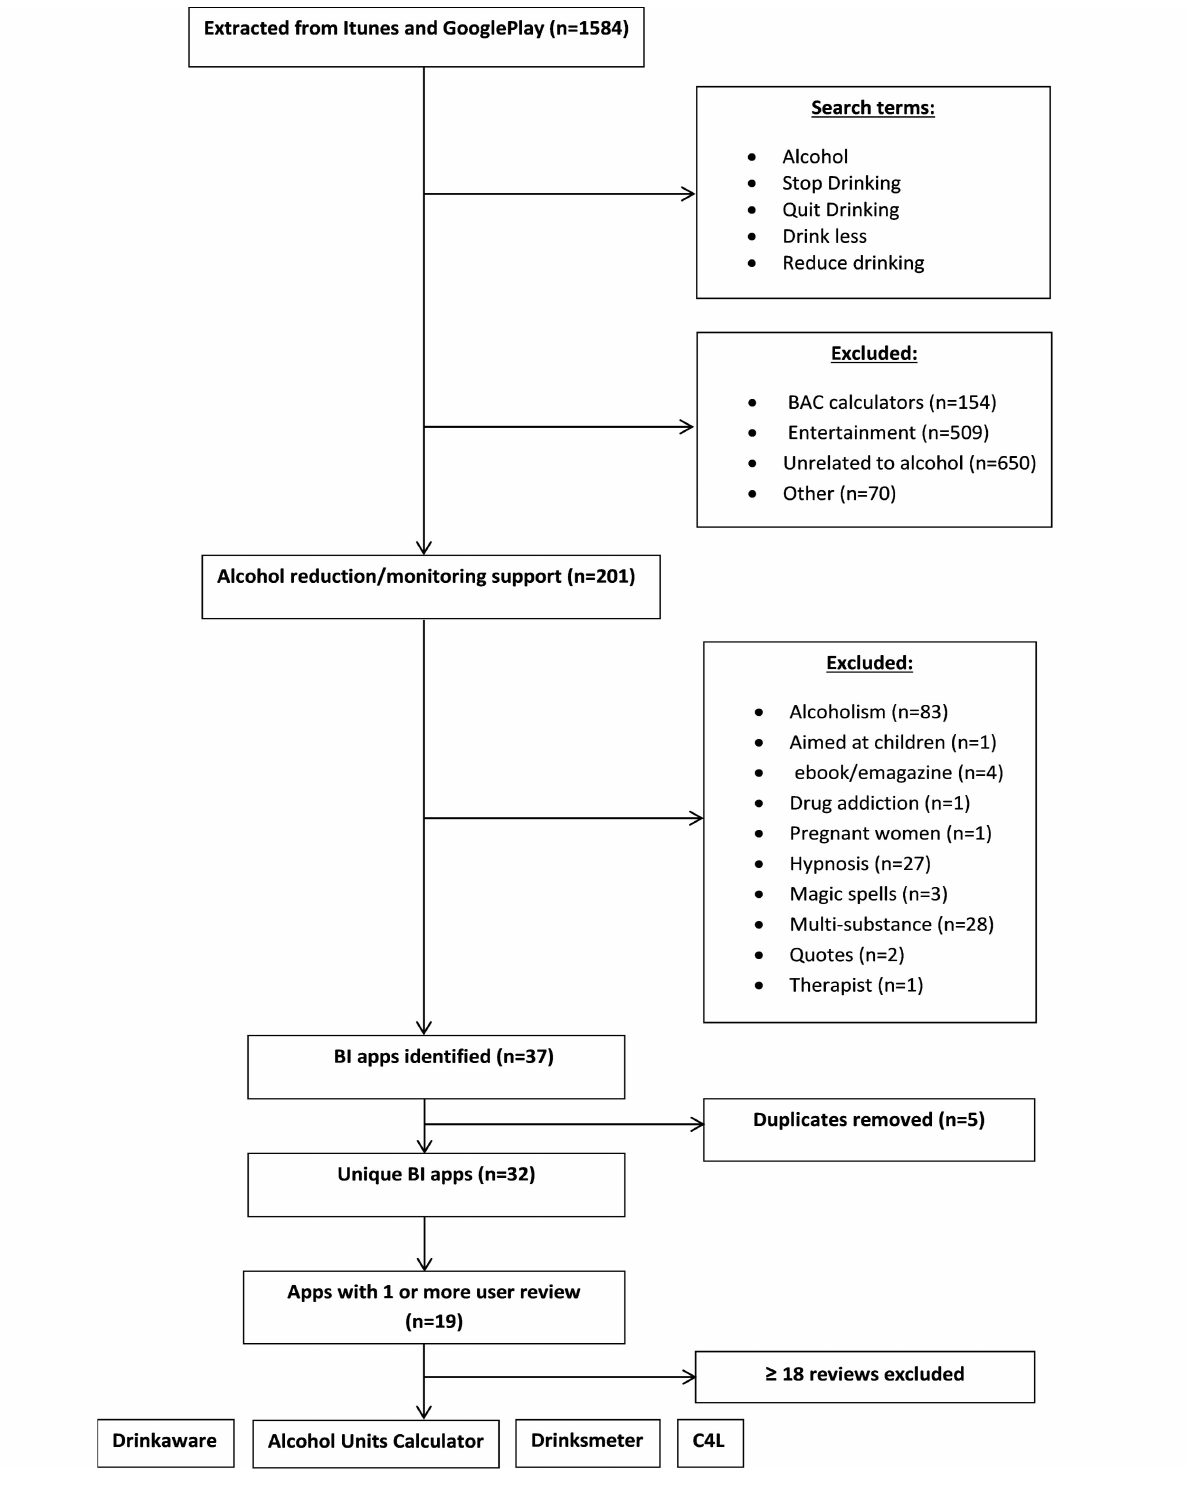
Figure 1. Flow diagram of apps selected for